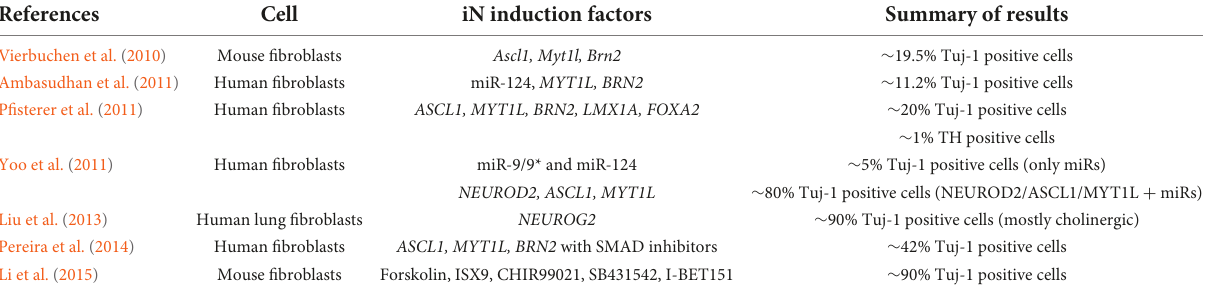
TABLE 1 Summary of iN attempts in previous studies (review and mechanistical analysis papers were